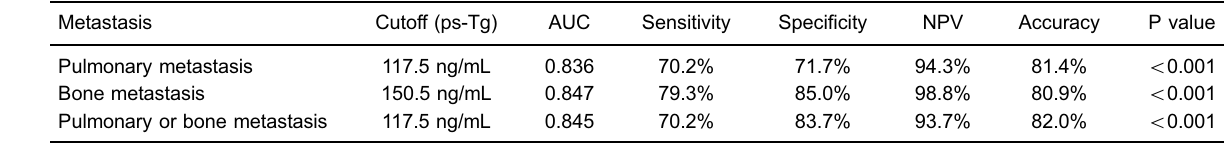
Ps-Tg: postoperative stimulated thyroglobulin; AUC: area under the curve; NPV: negative predictive